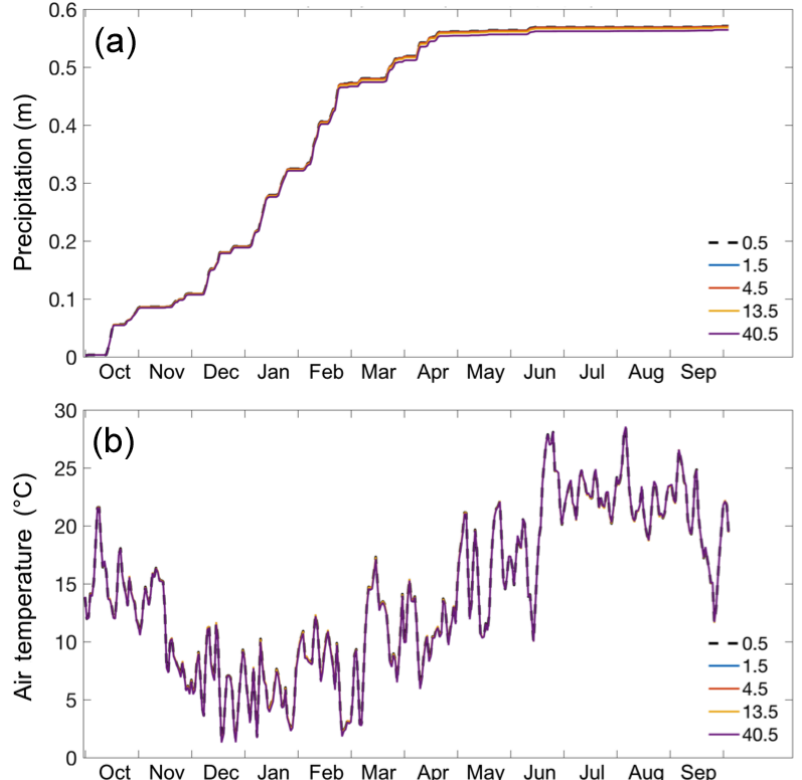
Figure A1. Daily variations of WRF-simulated precipitation (a) and air temperature (b) , averaged over the entire watershed for spatial resolutions of 0.5, 1.5, 4.5, 13.5, and